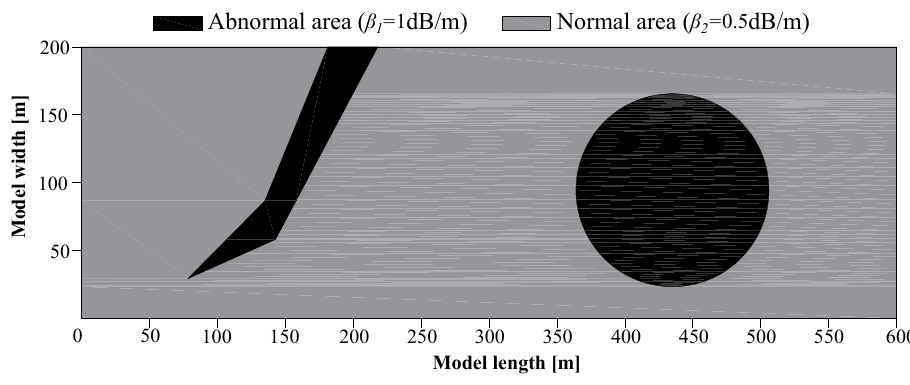
Figure 3. Reconstructed model with anomaly area.